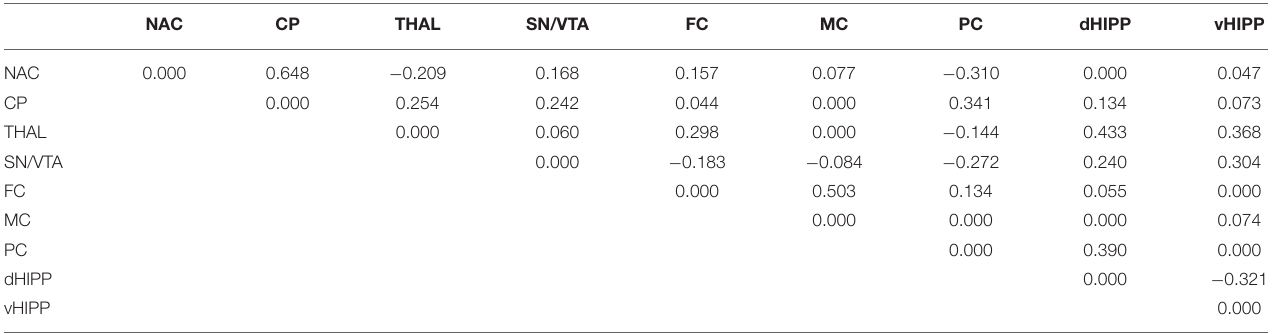
TABLE 4 | Path coefficient matrix after treatment with 2,5-dimethoxy-4-iodoamphetamine (DOI) obtained with EBICglasso modeling of D 2 / 3 R binding potentials in nucleus accumbens (NAC), caudate putamen (CP), thalamus (THAL), substantia nigra/ventral tegmental area (SN/VTA), frontal cortex (FC), motor cortex (MC), parietal cortex (PC), dorsal hippocampus (dHIPP), and ventral hippocampus